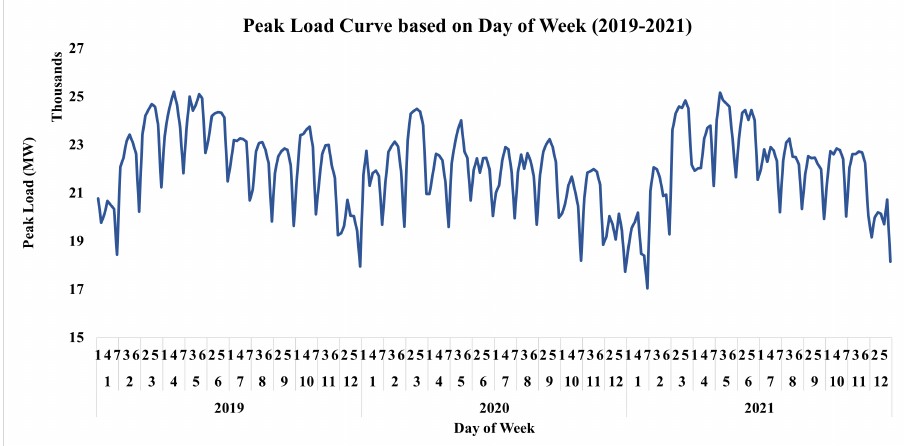
Figure 2. Variation in peak load based on day of week from 2019 to 2021.